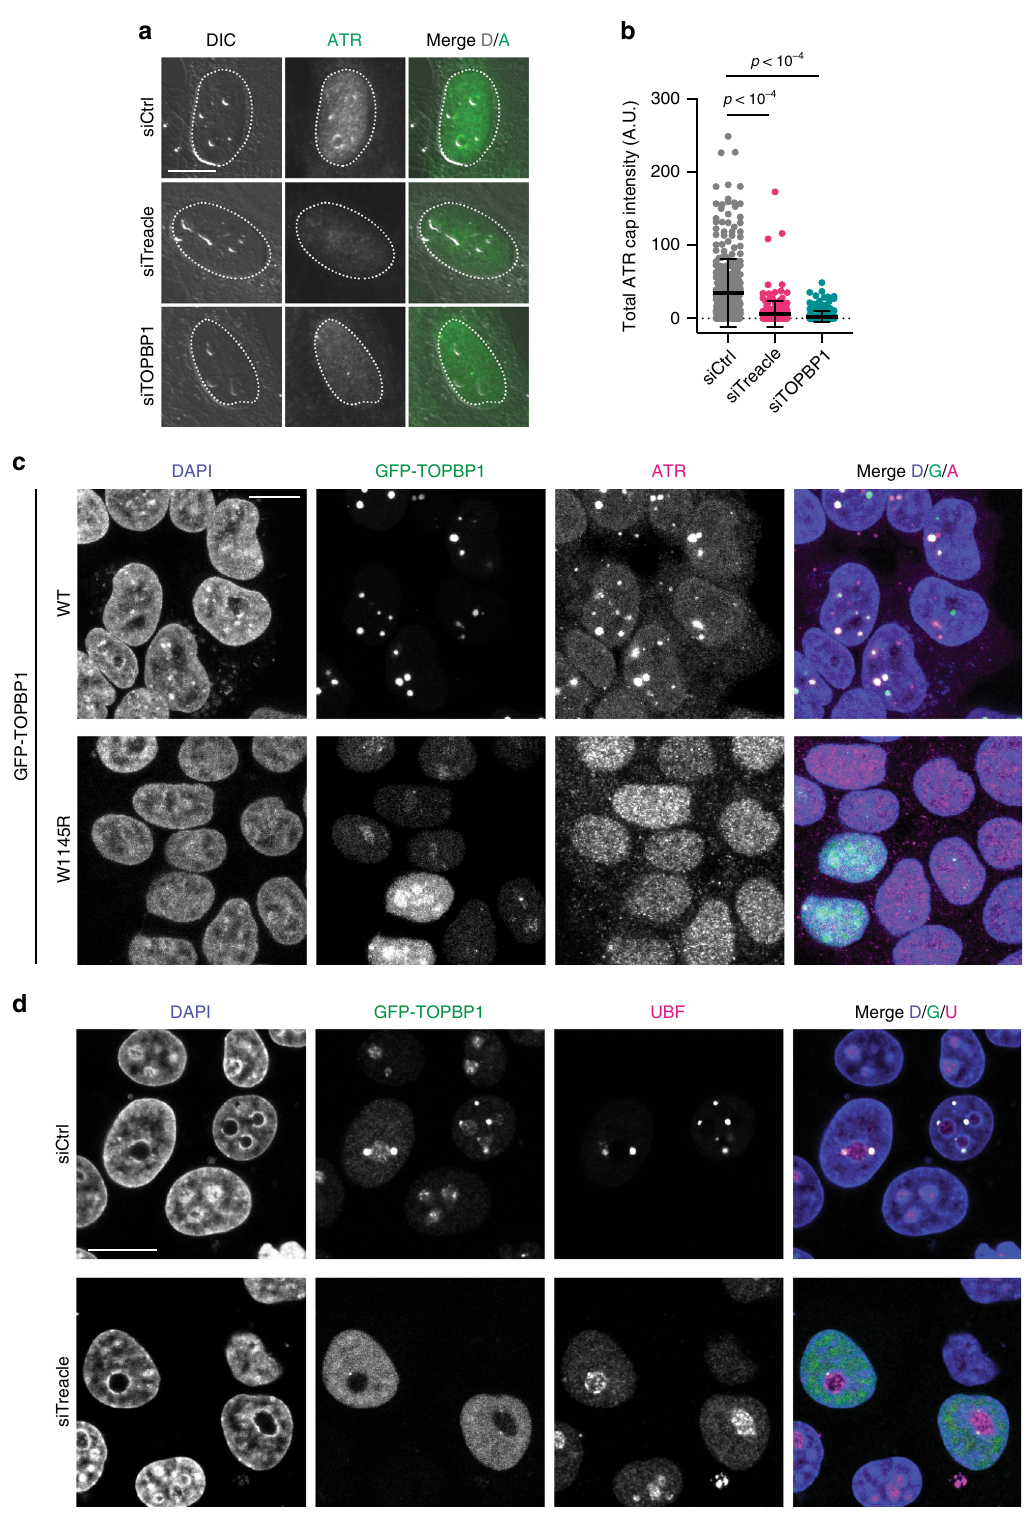
Fig. 7 Treacle- and TOPBP1-mediated nucleolar recruitment of ATR. a ATR localization in Treacle- and TOPBP1-depleted U2OS cells and control cells 2 h after I-Ppo1 transfection. b Quanti fi cation of the experiment in a , siCtrl ( n = 364), siTreacle ( n = 214) and siTOPBP1 ( n = 245) treated cells. Statistical signi fi cance was calculated using a one-way analysis of variance and Sidak ’ s multiple comparison test. Bars represent mean ± S.D. c ATR localization in 293-T cells overexpressing GFP-TOPBP1 wild type and W1145R AAD point mutant. d UBF localization in Hela cells overexpressing GFP-TOPBP1 and transfected with control siRNA and Treacle siRNA, respectively. All scale bars = 10 µ m. Source data are provided as a Source Data fi